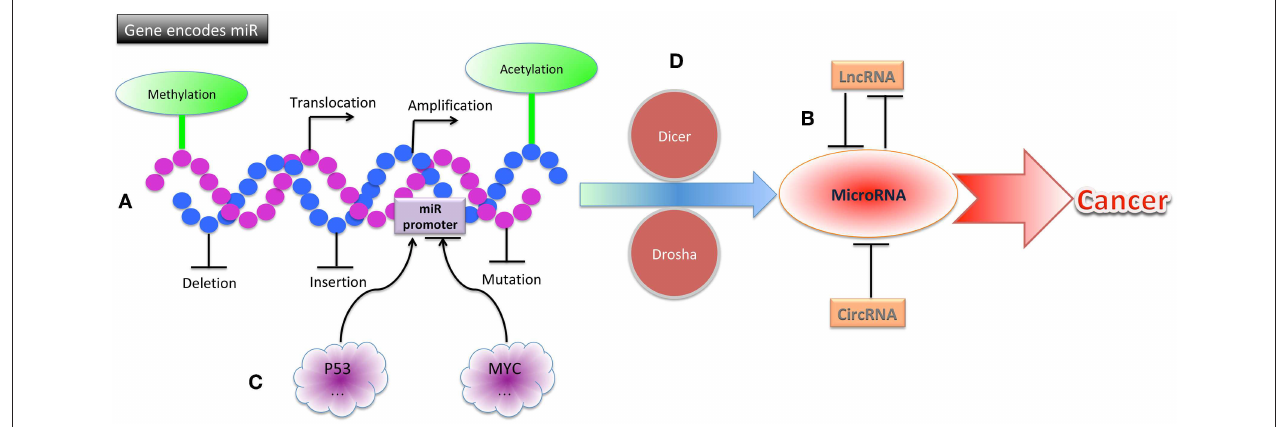
FIGURE 2 | The mechanisms of miRNA dysregulation in cancers. (A) Structural gene alterations, including translocation, amplification, deletion, insertion, and mutation contribute to miRNA dysregulation in cancers. (B) Epigenetic alterations, including methylation, acetylation, lncRNAs, and circRNAs contribute to miRNA dysregulation in cancers. (C) MiRNA promoters can be altered by p53, MYC, and other transcription factors, leading to cancer. (D) Alterations of proteins involved in miRNA processing, including Dicer, Drosha, and others, can result in